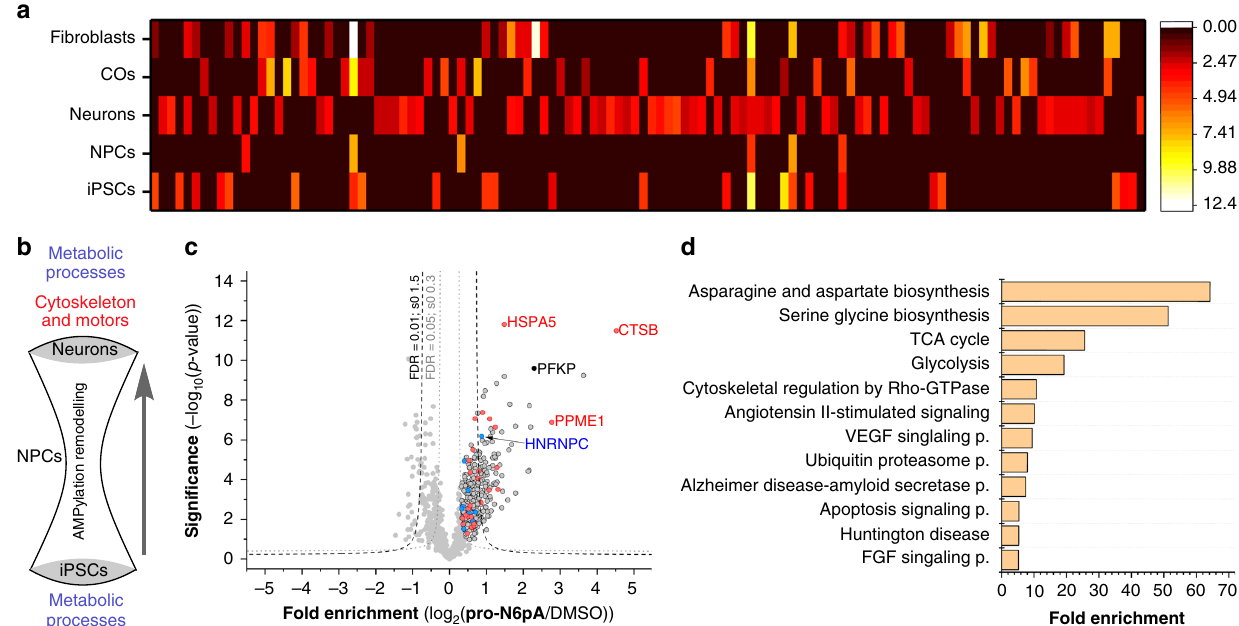
Fig. 4 AMPylation remodelling is speci fi c for the development of the neuronal cells. a Heatmap representation of enriched proteins identi fi ed in different cell types and COs. Colour represents distance to zero of enriched proteins from respective volcano plot (FDR 0.05, s0 0.3; n = 8 or 9). b The hourglass model of AMPylation remodelling hypothesises a complete de- and re-AMPylation in the process of neuronal differentiation: from a high number of AMPylated proteins in proliferative iPSCs, most of which are involved in metabolic processes and possess catalytic activity, differentiating cells pass through a state of very sparse AMPylation as NPCs, with fi nal neuronal differentiation resulting in neuronal identity with a high number of newly and uniquely AMPylated proteins which are enriched in metabolic functions on the one hand and in cytoskeletal and molecular motor functions on the other hand. c Volcano plot of fold-enrichment by pro-N6pA labelling compared to DMSO versus signi fi cance upon two-sample t -test (FDR 0.05, s0 0.3; n = 9) in fi broblasts. Red circles represent proteins identi fi ed AMPylated in proliferating cell types while blue circles stand for overlap with hits in neurons. d Panther Pathways enriched within the identi fi ed AMPylated proteins in all tested cell types, cut-off FDR